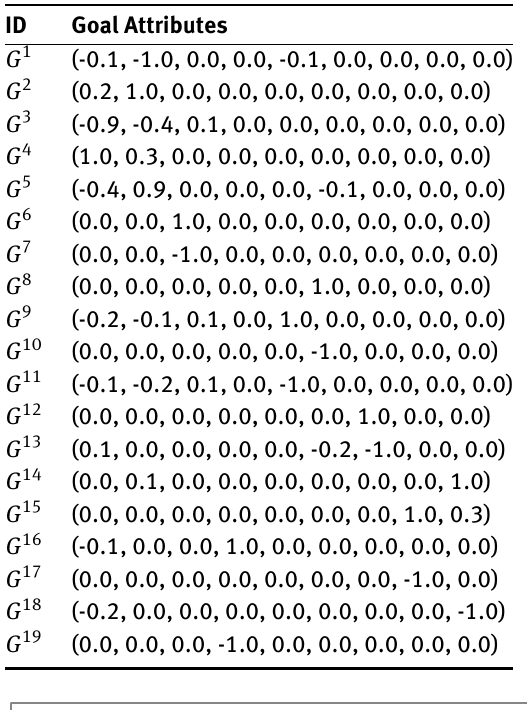
Table 7: Achievement goal prototypes generated in the first run of experiment 3 with ρ A = 1.0. Weights are rounded to 1 decimal place.